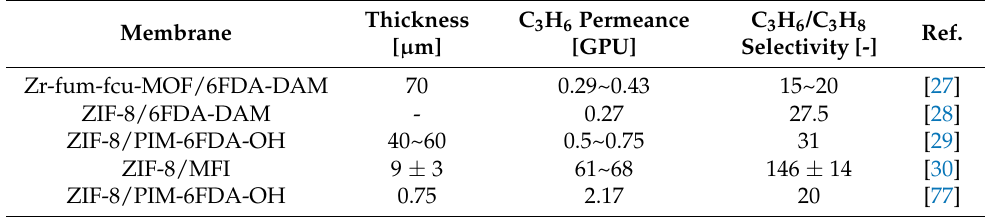
Table 9. Separation performance of C 3 H 6 /C 3 H 8 for